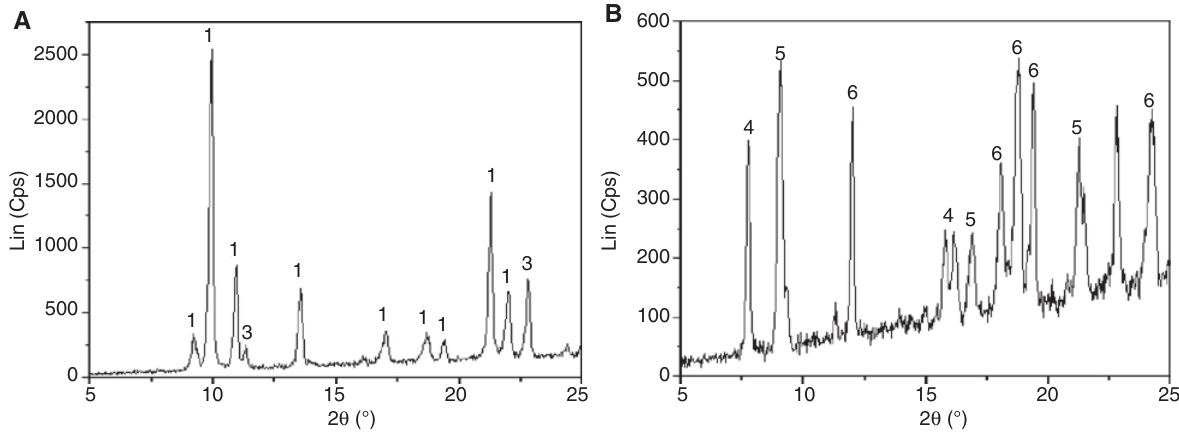
Figure 7: X-ray diffraction patterns of Cu-BTC, formed from Cu and benzene-1,3,5-tricarboxylic acid, synthesized in DD1 with an applied potential of 5 V/saturated calomel reference electrode (SCE) during (A) 10 min and (B) 60 min (1-Cu-BTC 1D, 3-C